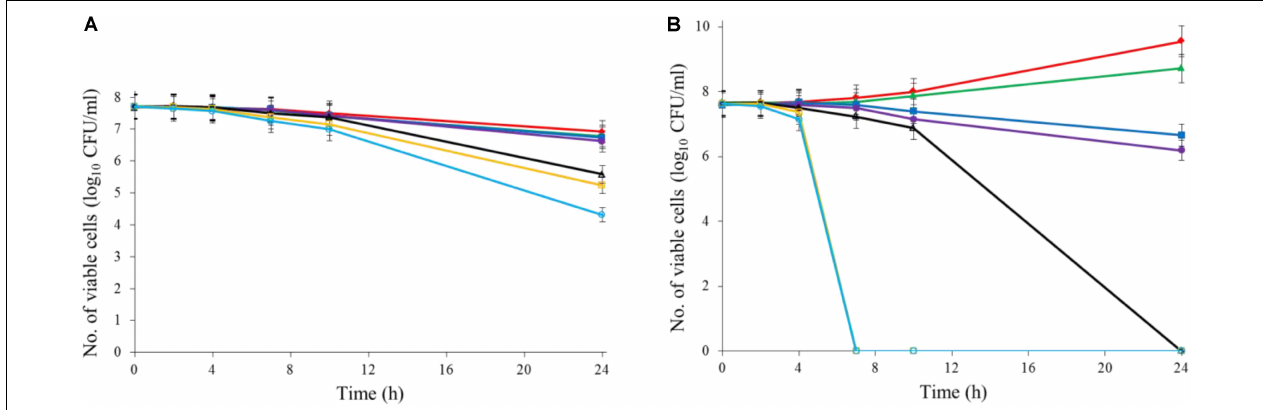
FIGURE 1 | Ajoene treatment on C. jejuni cocktail (the mixture of C. jejuni strain F38011, ATCC 33560, y110539, and z110526) resulted in a bacteriostatic effect at 22 ◦ C (A) and a bactericidal effect at 37 ◦ C (B) . Different symbols indicate different concentrations of ajoene (red line: 0 mM; green line: DMSO; blue line: 0.06 mM;